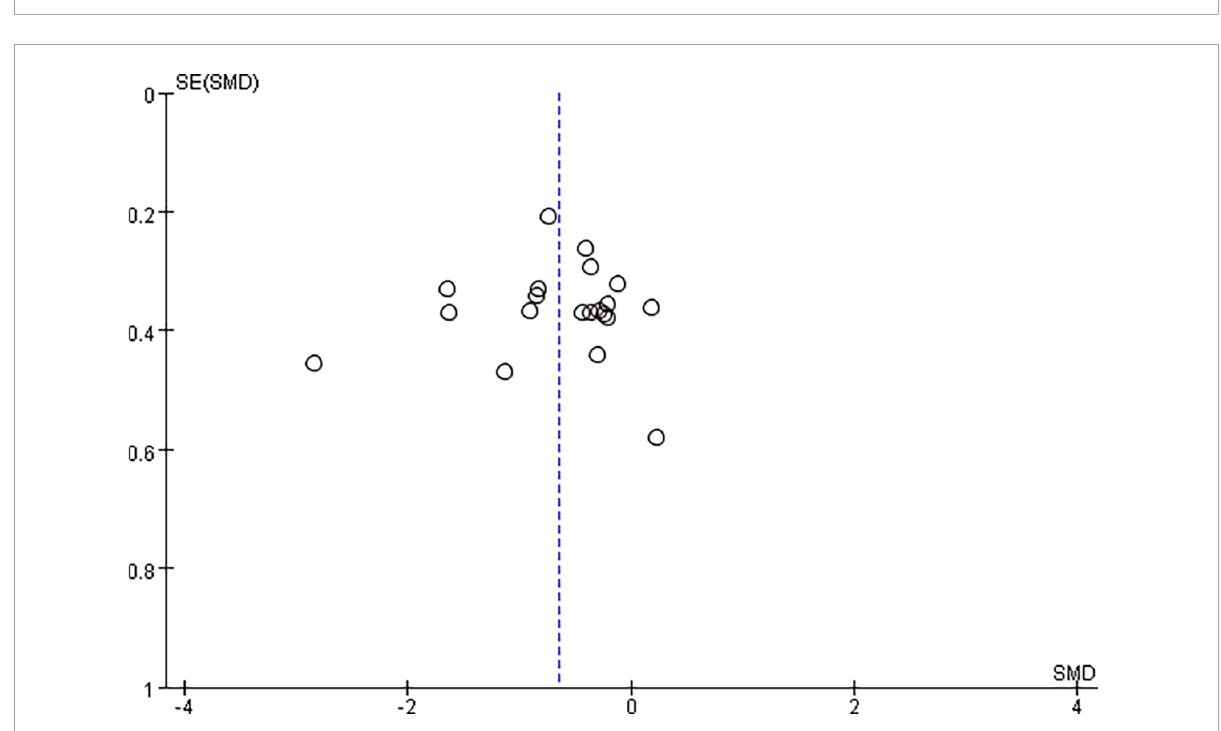
FIGURE4 The funnel plot of MAS in comparison of rTMS plus CR versus sham rTMS plus CR.